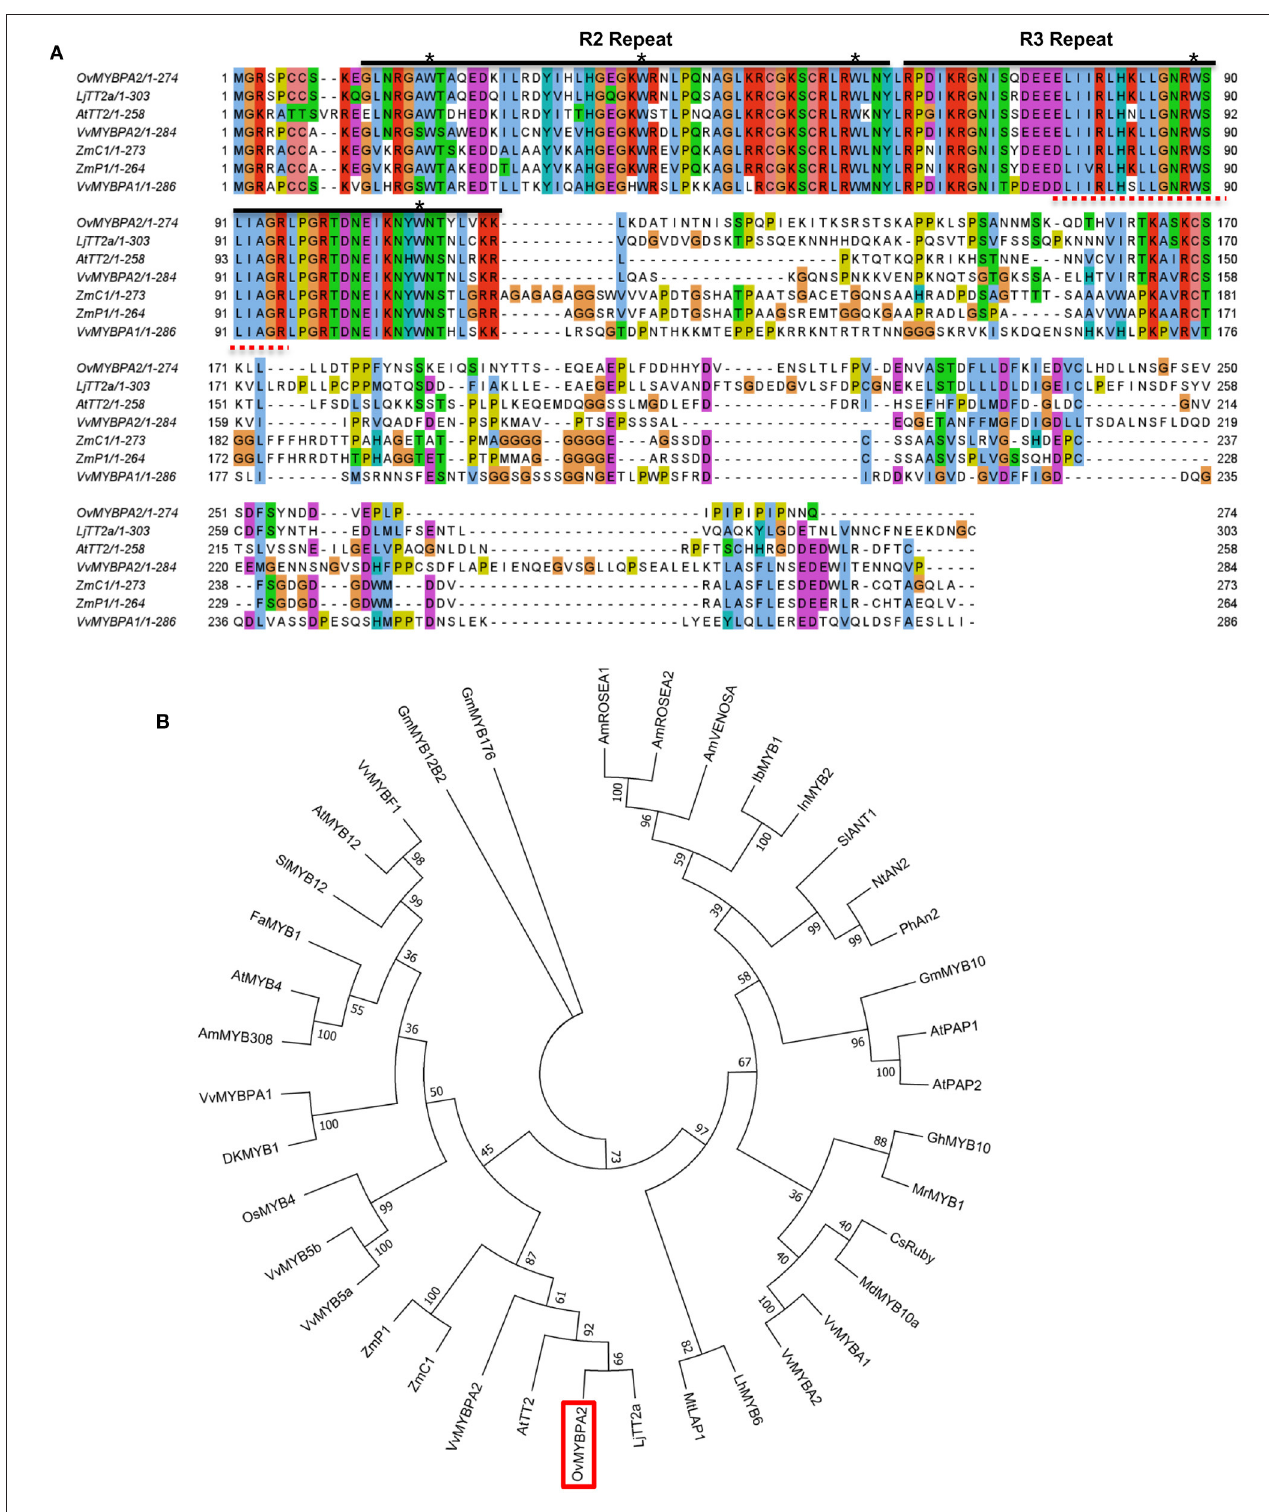
FIGURE 5 | Multiple sequence alignment and evolutionary relationship of OvMYBPA2. (A) Alignment of amino acids sequence of OvMYBPA2 with other MYBs (e.g., LjTT2a, AtTT2, VvMYBPA1, VvMYBPA2, ZmC1, and ZmP1) that were related to proanthocyanidins biosynthesis. The R2 and R3 repeats of MYB conserved domain were marked with black line. The five asterisks indicate conserved W residues. The bHLH-binding domains were indicated in dashed red lines (B) phylogenetic analysis of OvMYBPA2 and other MYB proteins related to proanthocyanidins, anthocyanidins, and flavonoid biosynthesis. OvMYBPA2 was highlighted with a red box. The sequence information for all the MYB transcription factors was downloaded from the GenBank database and listed in Supplementary Table 3 .